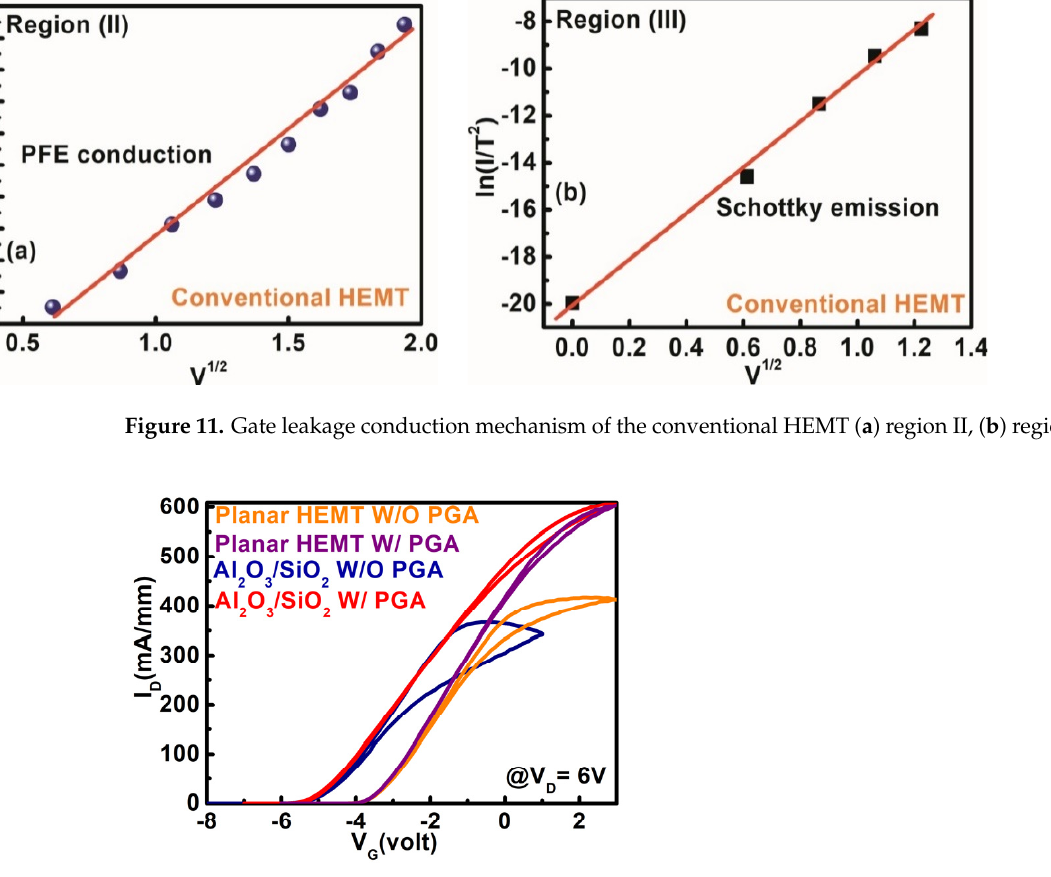
Figure 12. Hysteresis characteristics of the conventional HEMT and Al 2 O 3 /SiO 2 MOS–HEMT with and without PGA treatment.